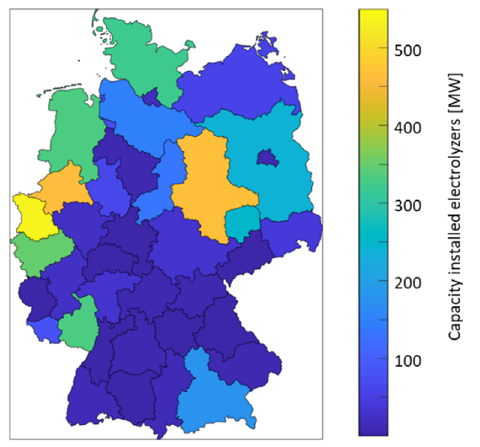
Figure 16. Regional distribution of electrolyzers.